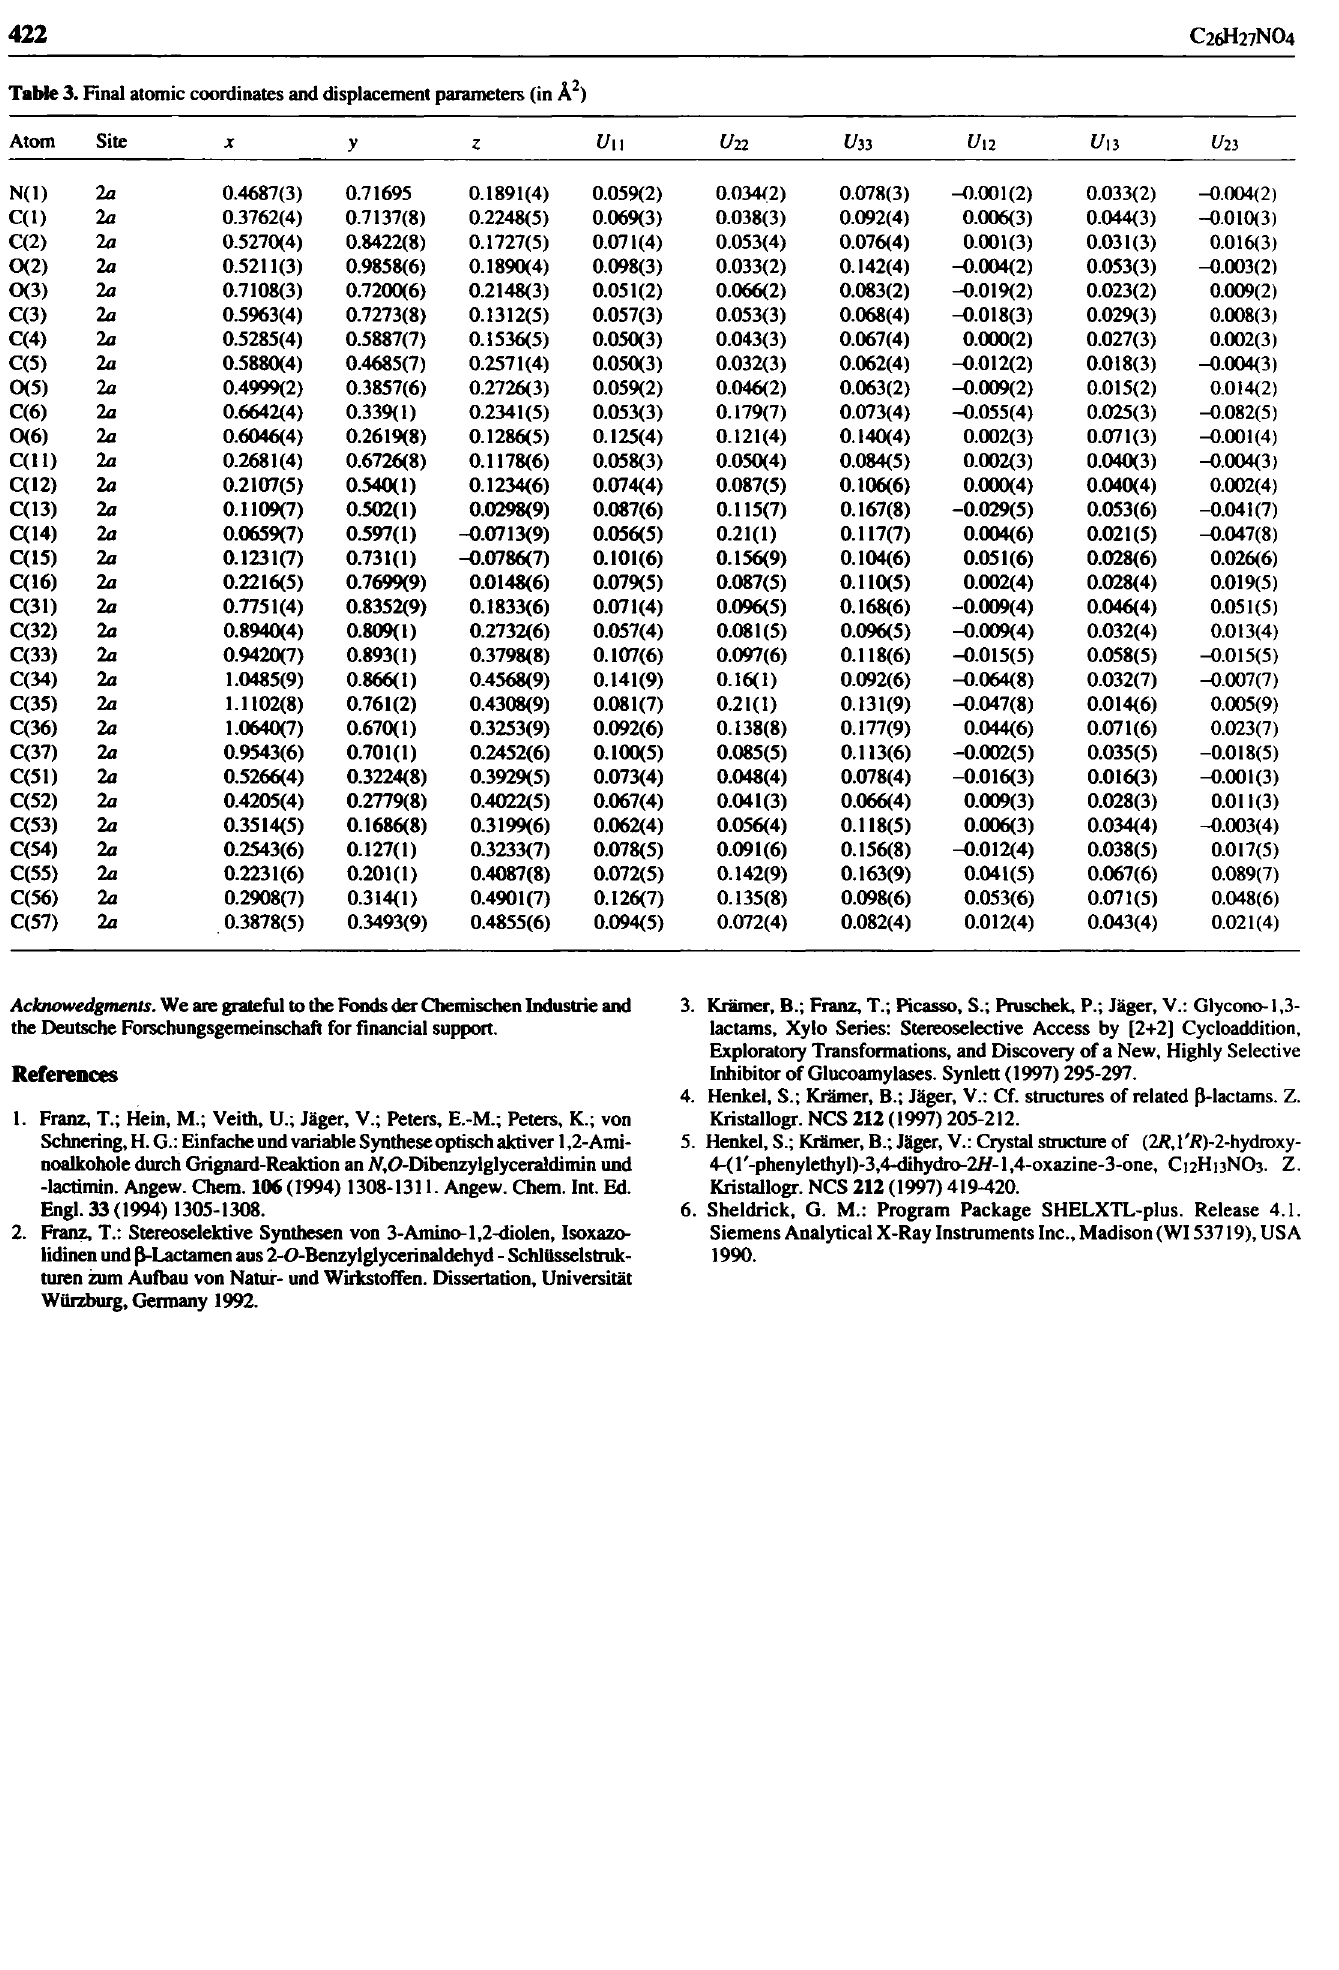
Table 3. Final atomic coordinates and displacement parameters (in Â 2